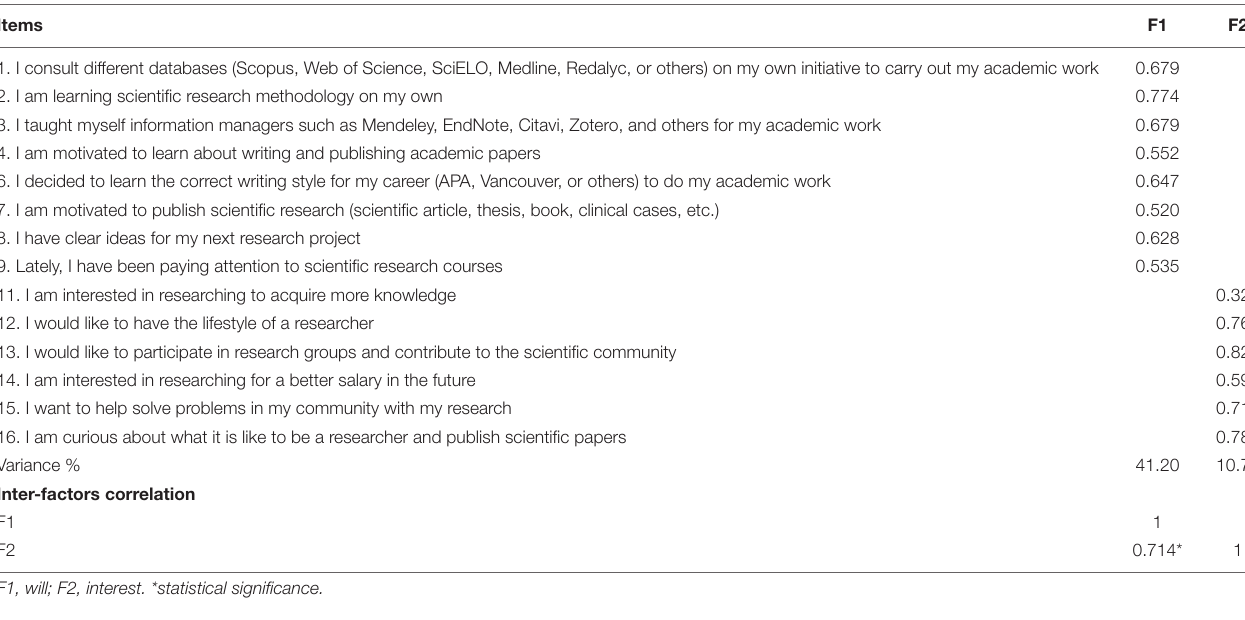
TABLE 3 | Exploratory factor analysis of the MoINV-U scale.